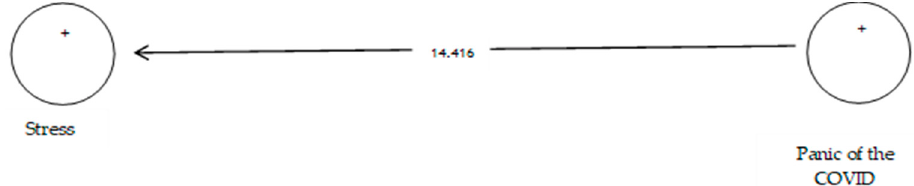
Figure 22. The tenth sub-hypothesis model includes factor load coefficients.